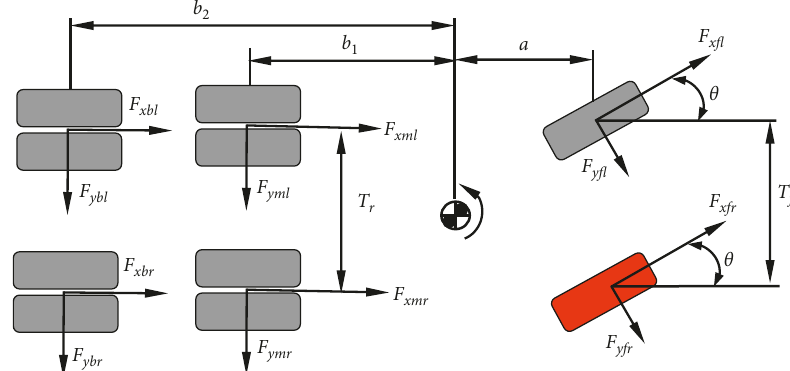
Figure 1: Vehicle dynamic model with complete brake failure (right front